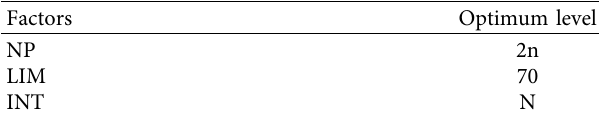
Figure 9: Graph of average S / N ratio for each level of INTfactor of PSO algorithm in model solving. Table 7: Optimal parameters and operators of ABC algorithm.